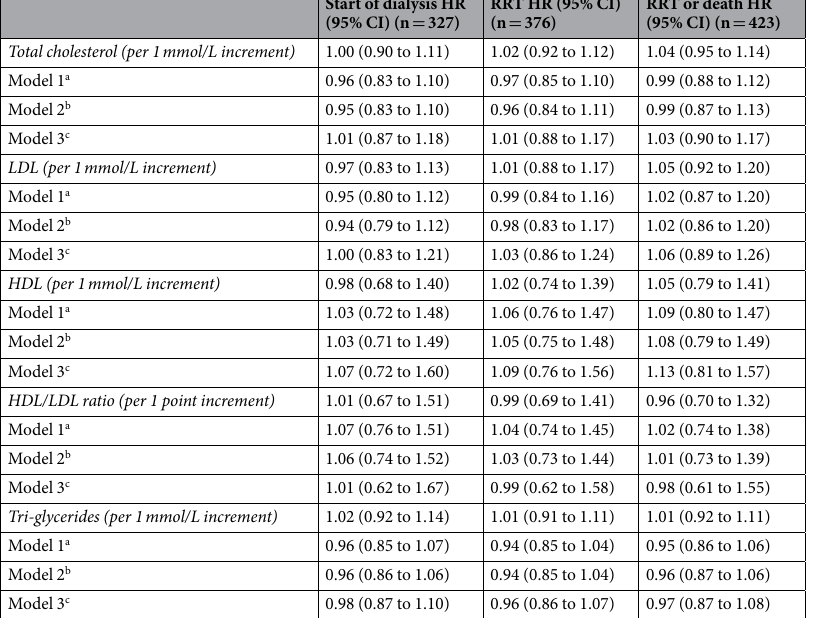
Table 4. Crude and adjusted hazard ratio (95% CI) according to continuous levels of serum lipids or triglycerides for start of dialysis, RRT and combined endpoint (n = 502). a Model 1 was adjusted for; age, sex, ethnicity, current smoker, body mass index, diabetes mellitus, hypertension, proteinuria and primary kidney disease. b Model 2 was adjusted for: model 1 + CRP, Albumin, Subjective Global Assessment. c Model 3 was adjusted for: model 2 + Lipid-lowering medication use. CI: confidence interval, n:number, RRT: Renal Replacement